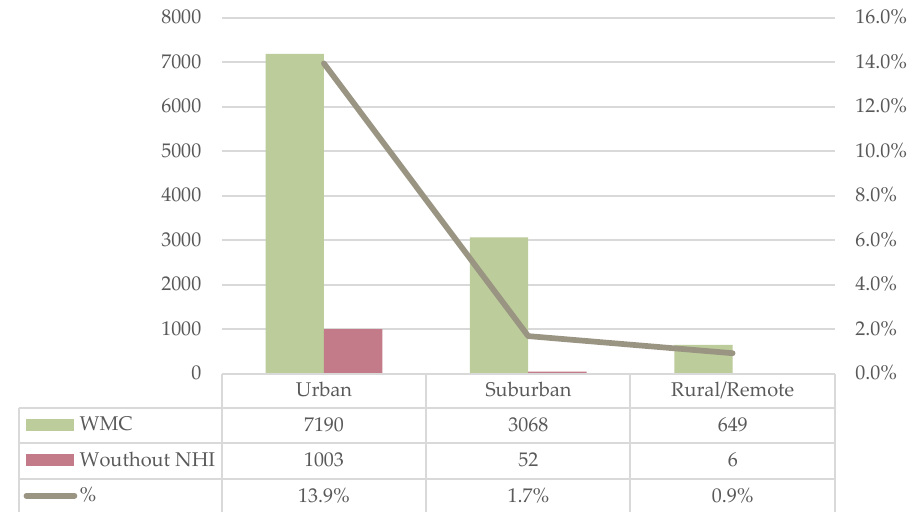
Figure 2. Urbanization level of the location of clinics without health insurance. WMC: Western Medical Clinic.